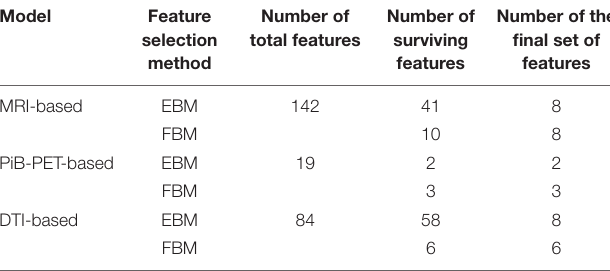
TABLE 4 | List of the regions used for extracting features that will be used in the construction of the individual